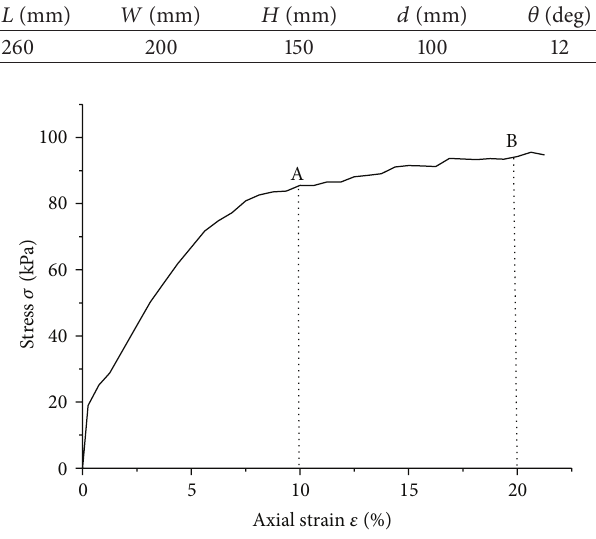
Figure 3: Stress-strain curve of the sample soil: A is theoretically considered as the yield point; B is theoretically considered as the failure point.